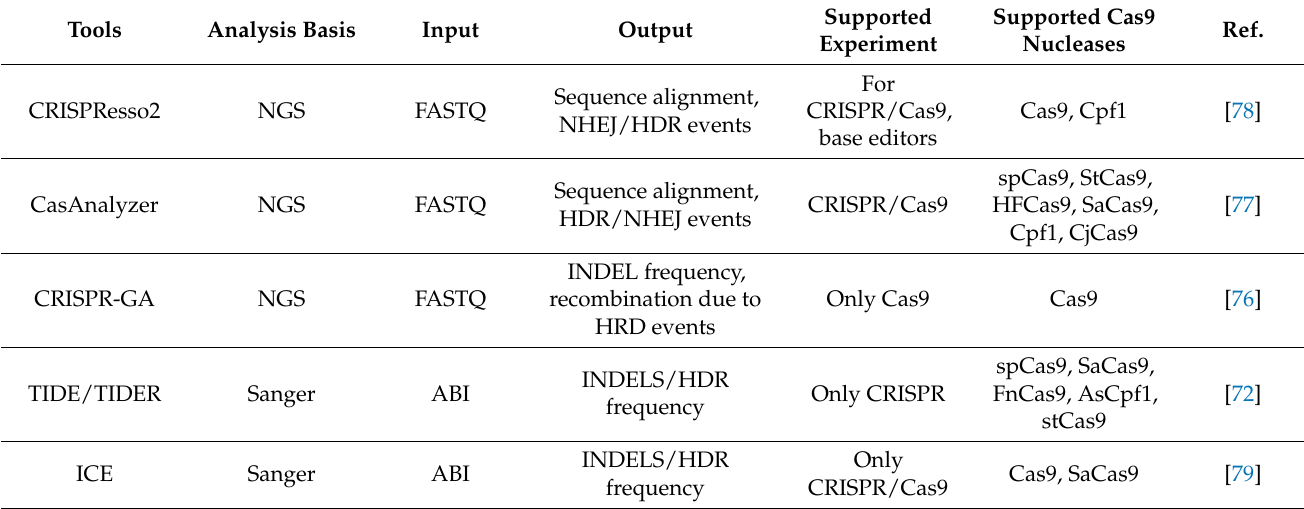
Table 4. Tools for post-experiment off-target